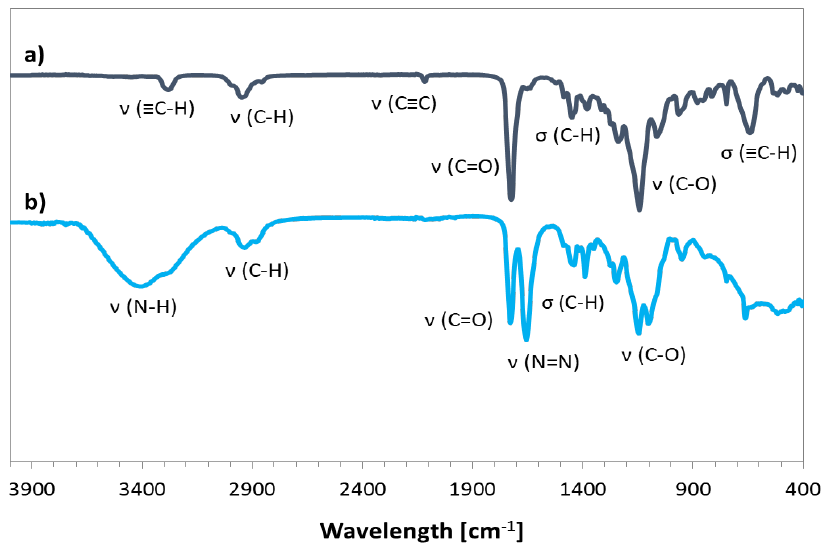
Figure 7. FT-IR spectra for P(AlHEMA- co -MMA) ( a ) and P((HEMA- graft -PEG)- co -MMA) ( b ) .